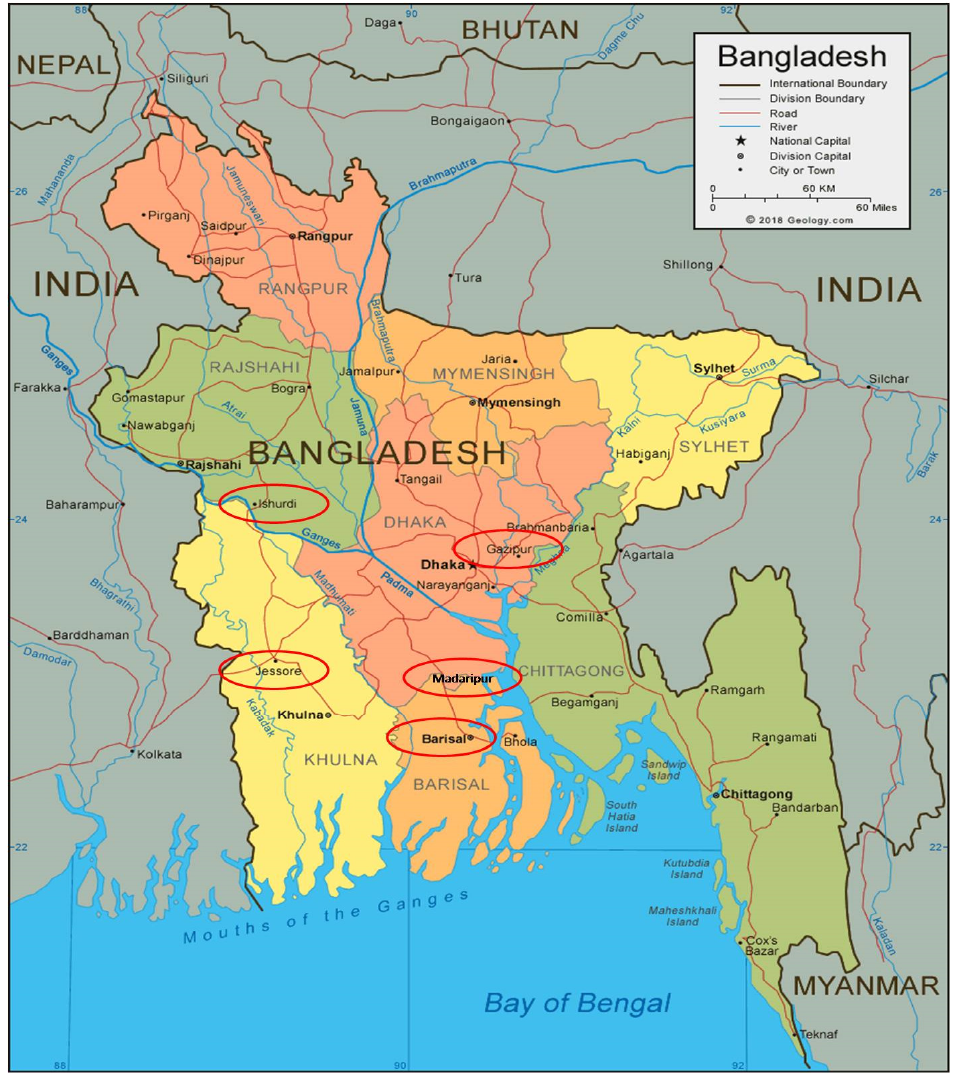
Figure 1. The geographical location of five experimental sites (within the red circle) in Bangladesh.